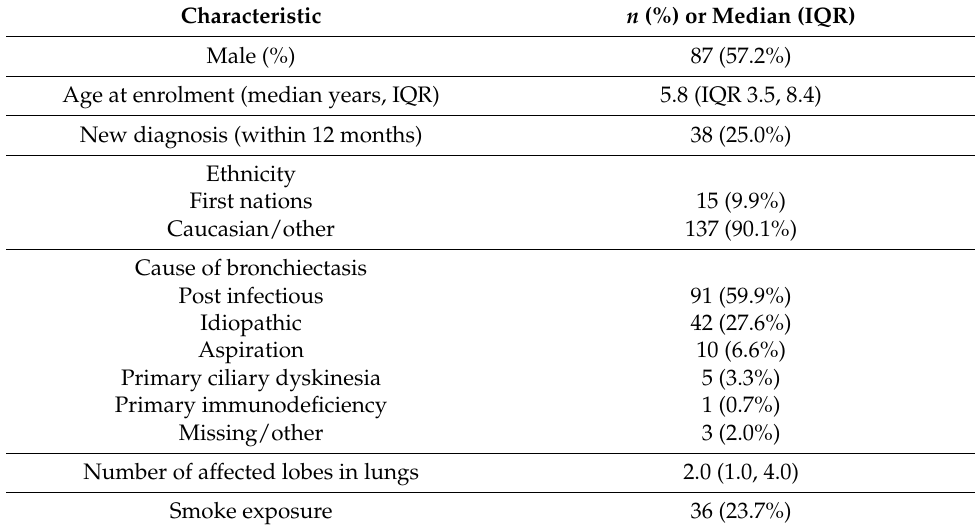
Table 1. Characteristics of 152 children with bronchiectasis.